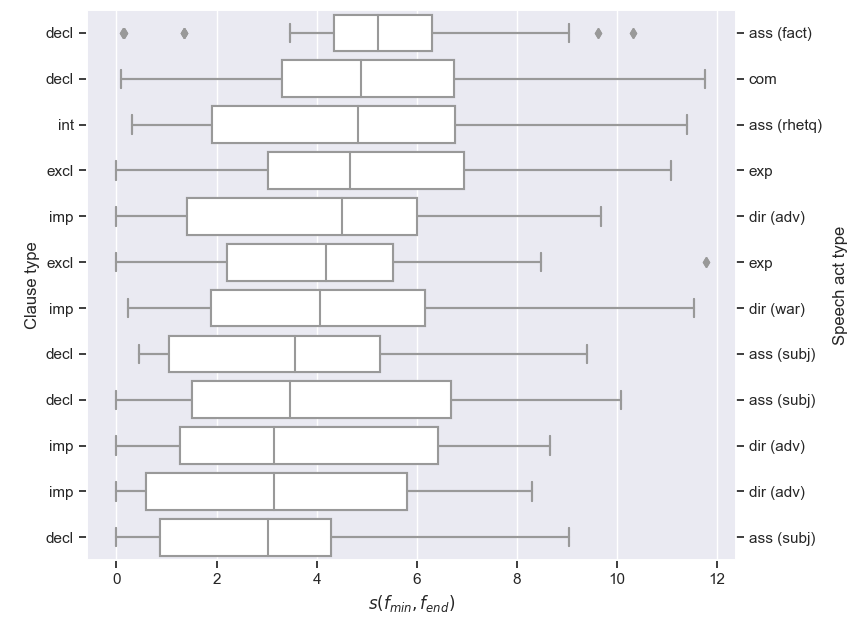
Figure 8. The pitch span of the tag in semitones according to clause type and speech act